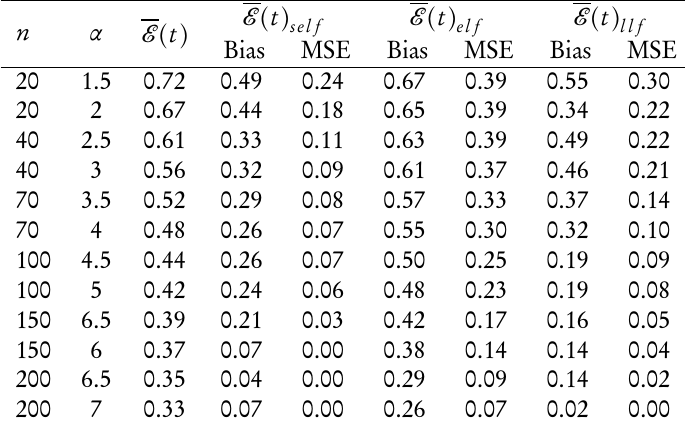
The bias and MSE of important sampling procedure for Bayes estimators of (cid:69) ( t ) using c = 2 and h = 2 .